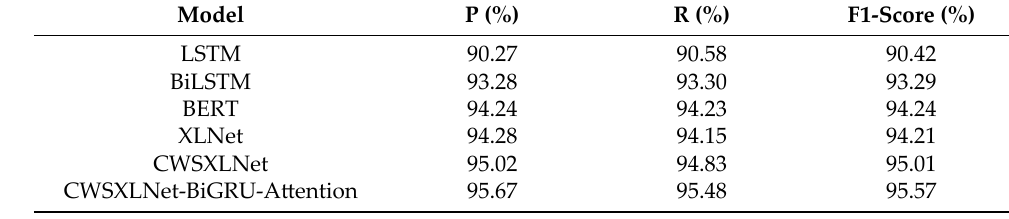
Table 6. Weibo_senti_100k dataset experimental results.